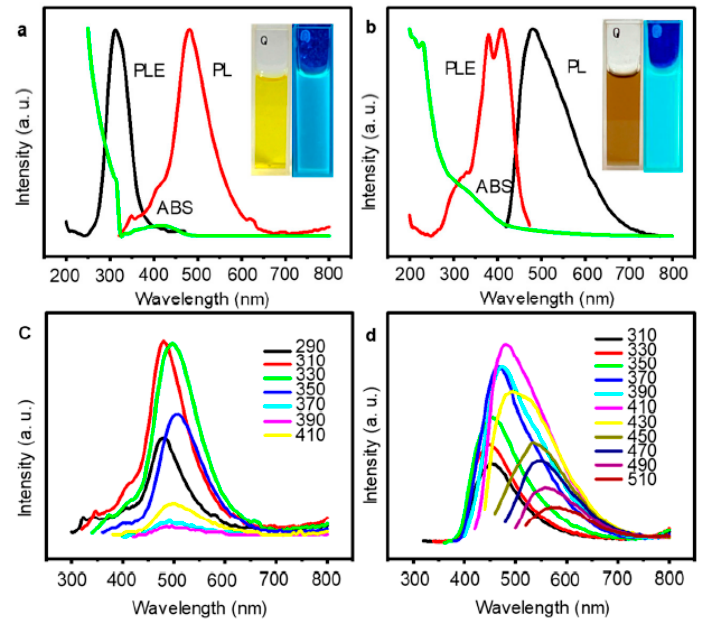
Figure 3. The UV absorption spectra, fluorescence excitation spectra and fluorescence emission spectra of GQDs ( a ) and N − GQDs ( b ). The fluorescence spectrum of GQDs ( c ) and N − GQDs ( d ) under different excited wavelengths.